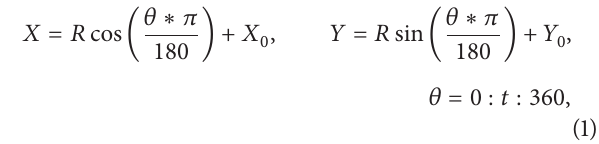
Figure 3: The detected hand